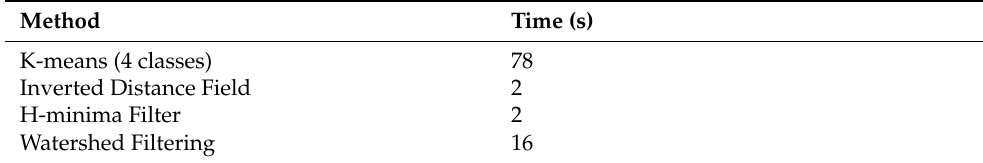
Table 4. Performance results of multiphase analysis.